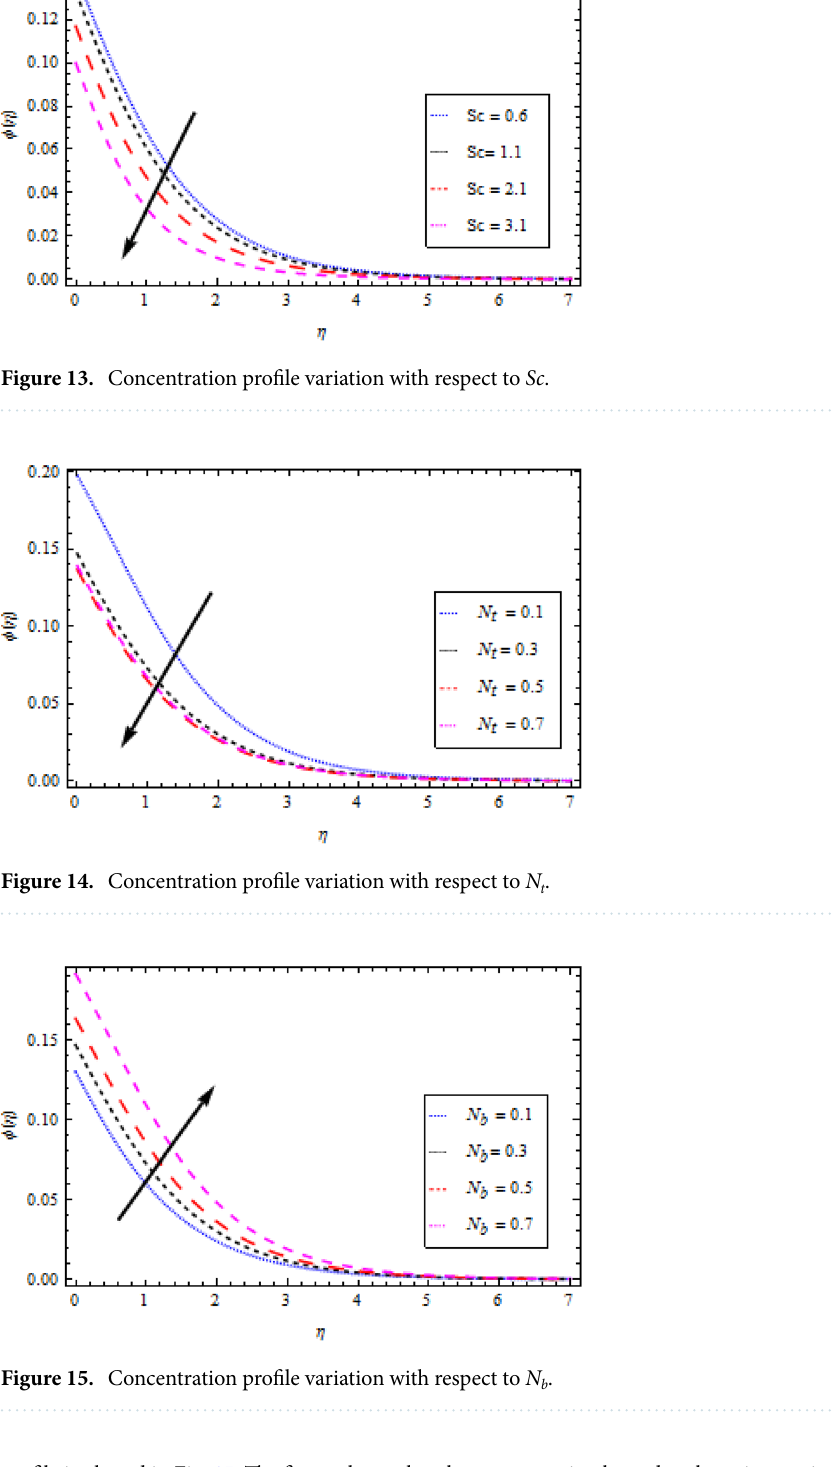
profile is plotted in Fig. 15. The figure shows that the concentration boundary layer is associated with increasing values of N b . Entropy generation. Figures 16, 17 and 18 are show graphs of different parameters versus entropy genera- tion. The reaction of entropy generation number N Gs to changes in temperature ratio θ b values are depicted in Fig. 16. An uplift in θ b decreases N Gs . With an increase in N r , entropy generation N Gs also increases, as shown in Fig. 17, which specifies that heat transmission irreversibility dictates entropy generation. It is noticed that